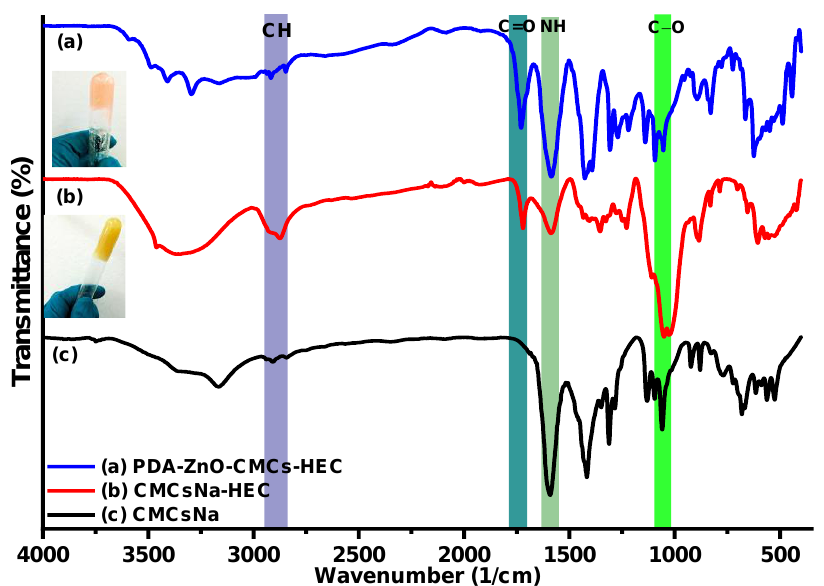
Figure 4. IR spectra of (a) PDA-ZnO-CMCs-HEC, (b) CMCs-HEC, and (c) CMCsNa. Inset CMCs-HEC hydrogels and PDA-ZnO-CMCs-HEC hydrogels.